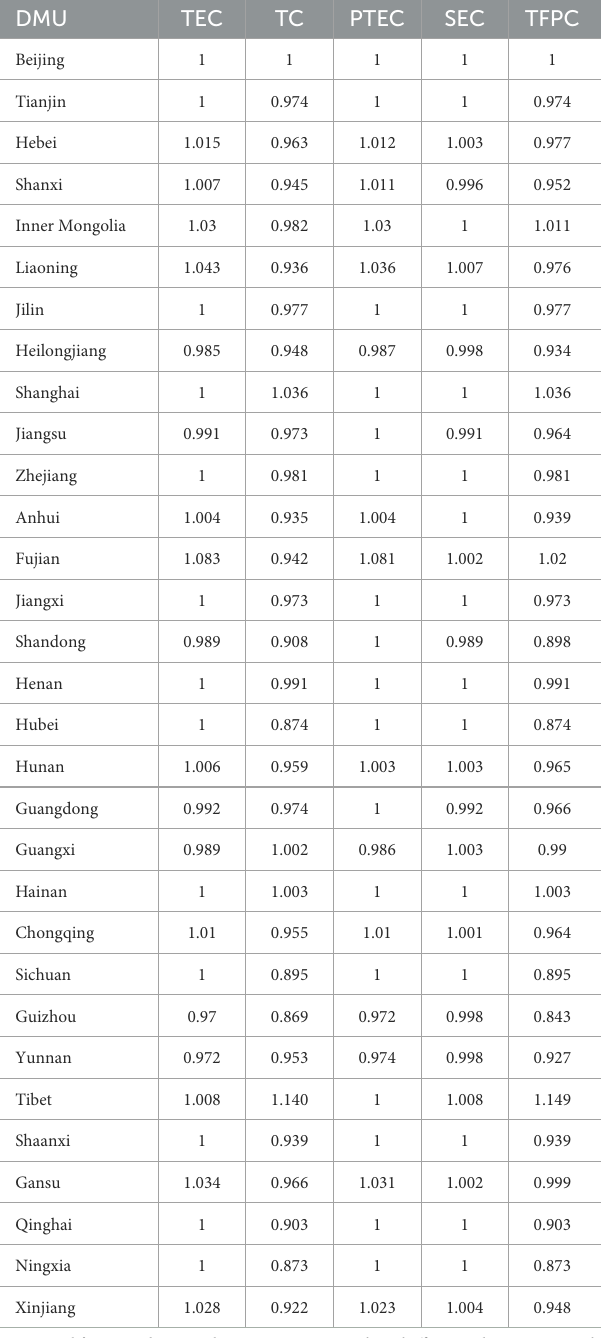
TABLE 2 Intertemporal analysis on the overall efficiency of LTCFs in 31 provinces